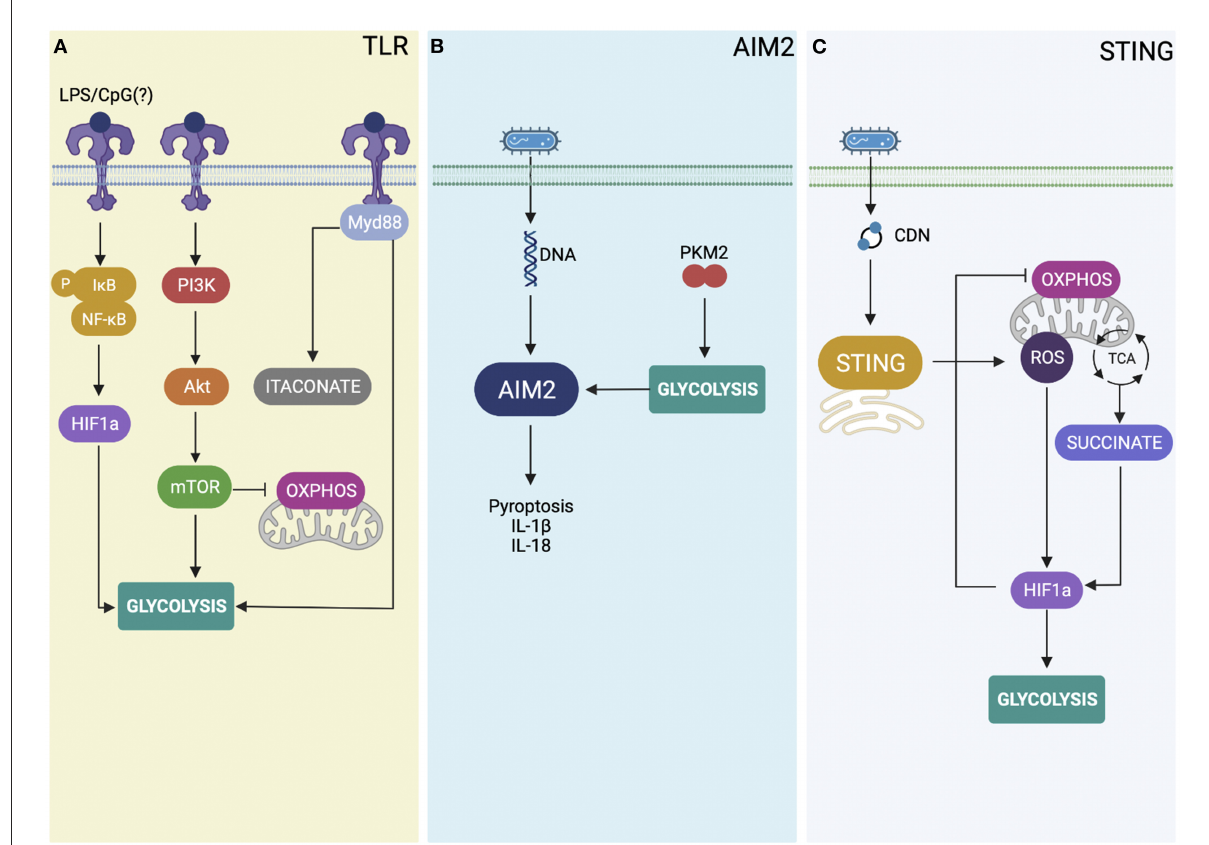
FIGURE1 Overview of the role of innate immune receptors in immunometabolism. (A) TLR (toll-like receptors) stimulation activates the NF- κ B (nuclear factor kappa B) pathway and the transcription factor HIF-1 α (hypoxia-inducible factor-1 α ), thereby inducting the metabolic reprogramming toward glycolysis. Additionally, TLR stimulation also activates the PI3K-AKT-mTOR (phosphatidylinositol 3-kinase-protein kinase B-mechanistic target of rapamycin) pathway, a signaling pathway that plays a critical role in inducing the metabolic reprogramming and glycolysis. Further, Brucella activates TLRs signaling through MyD88-dependent glycolysis that results in itaconate production and restriction of Brucella infection. (B) Bacterial DNA and the M2 isoform of pyruvate kinase muscle 2 (PKM2)-dependent aerobic glycolysis activates AIM2 leading to IL- β secretion and pyroptosis. (C) During B. abortus infection, STING activation increases intracellular succinate levels and mROS (mitochondrial reactive oxygen species) production that contributes to HIF-1 α stabilization. HIF-1 α drives the metabolic reprogramming in infected macrophages, increasing glycolysis and reducing OXPHOS (mitochondrial oxidative